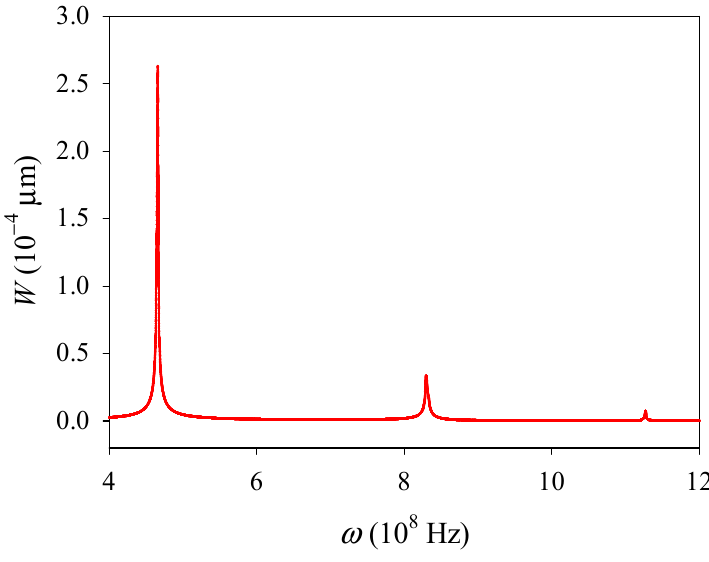
Figure 2. Deflection W versus the driving frequency ω . We then used the first-order natural frequency as the driving frequency ( ω = ω 1 ) and examined the first-order modal of the PSC plate. Due to the symmetry, all the distribution patterns of the electromechanical fields along the x -direction are the same as those along the y -direction. Therefore, only the electromechanical fields along the x -direction were analyzed. Shear displacement ψ x is antisymmetrically distributed around the central line x = l /2 (see Figure 3a), and extreme values occur at points ( l /4, d /2) and (3 l /4, d /2). The distributions of the deflection W , electric potential Φ , and electron concentration perturbation Δ N are similar, and all change uniformly. Extreme values all occur at the central point (see Figure 3b–d) due to the uniformly distributed load and the fixed boundary conditions. In addition, in Figure 3d, an electron redistribution phenomenon can be clearly observed. This phenomenon occurs due to electrons spontaneously move to the high potential region.